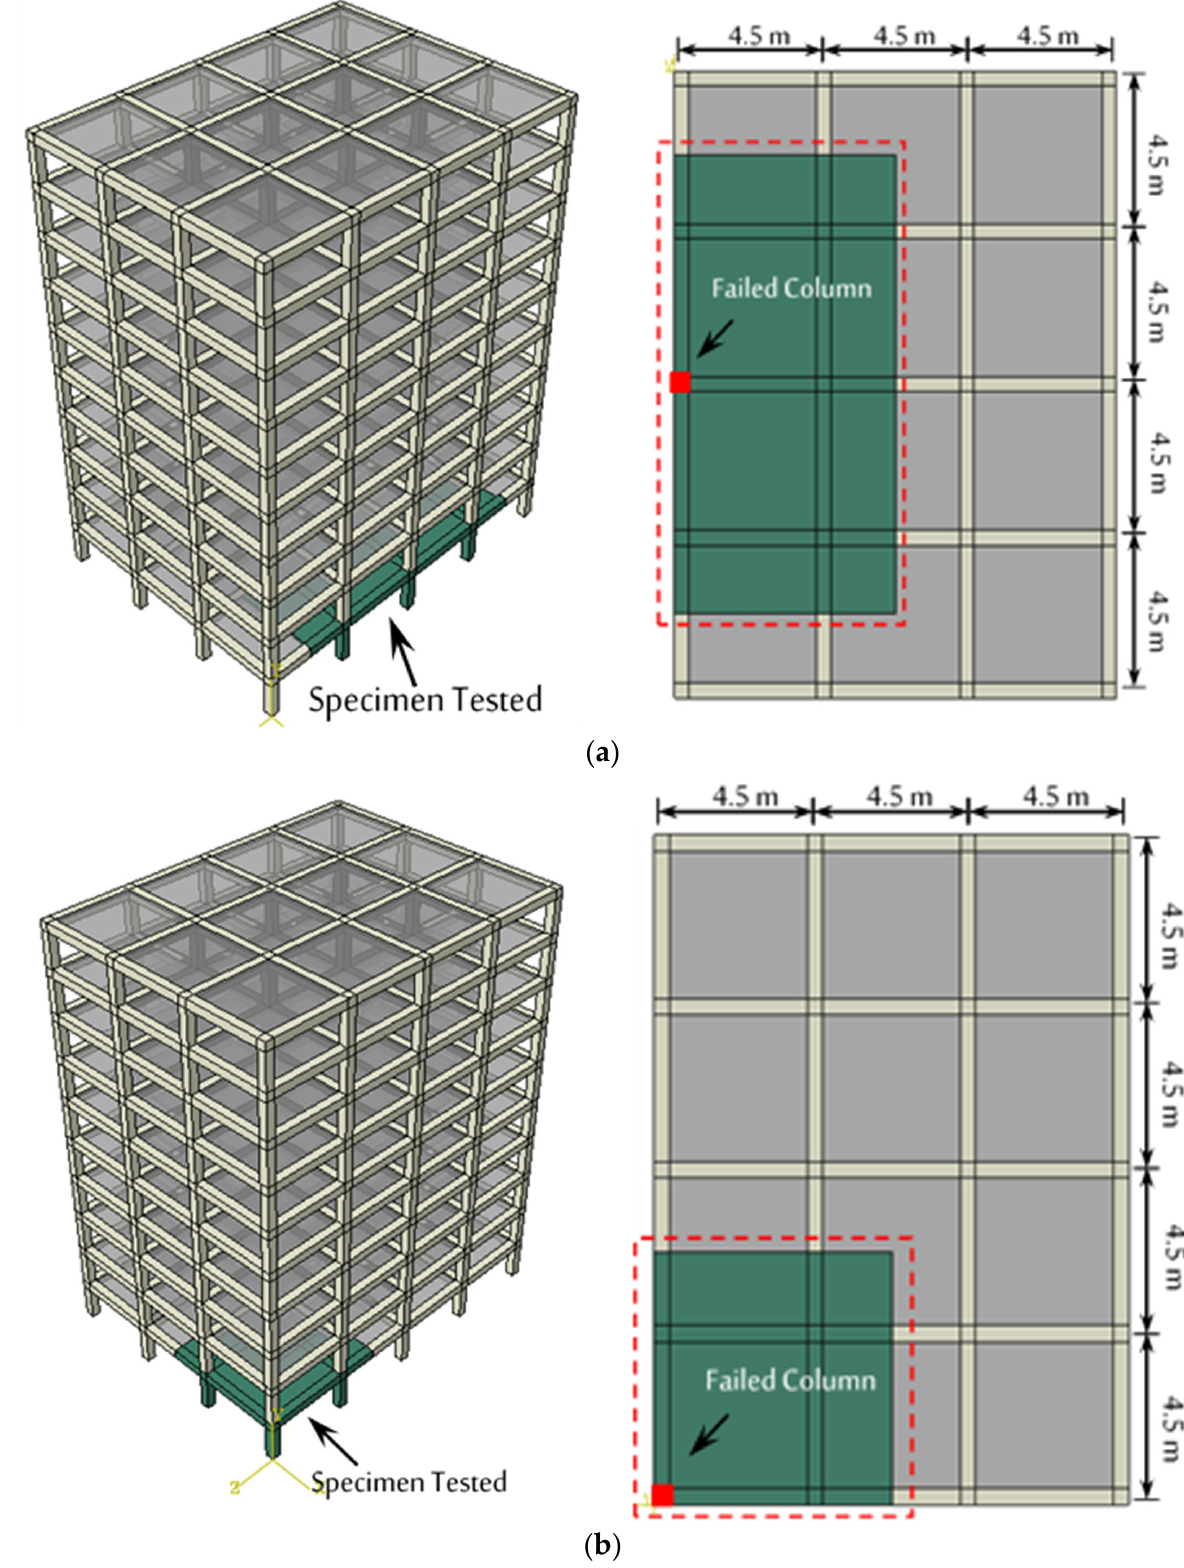
Figure 15. Beam–slab substructures used in the numerical study: ( a ) scenario “A” with middle column removed and ( b ) scenario “B” with corner column removed.